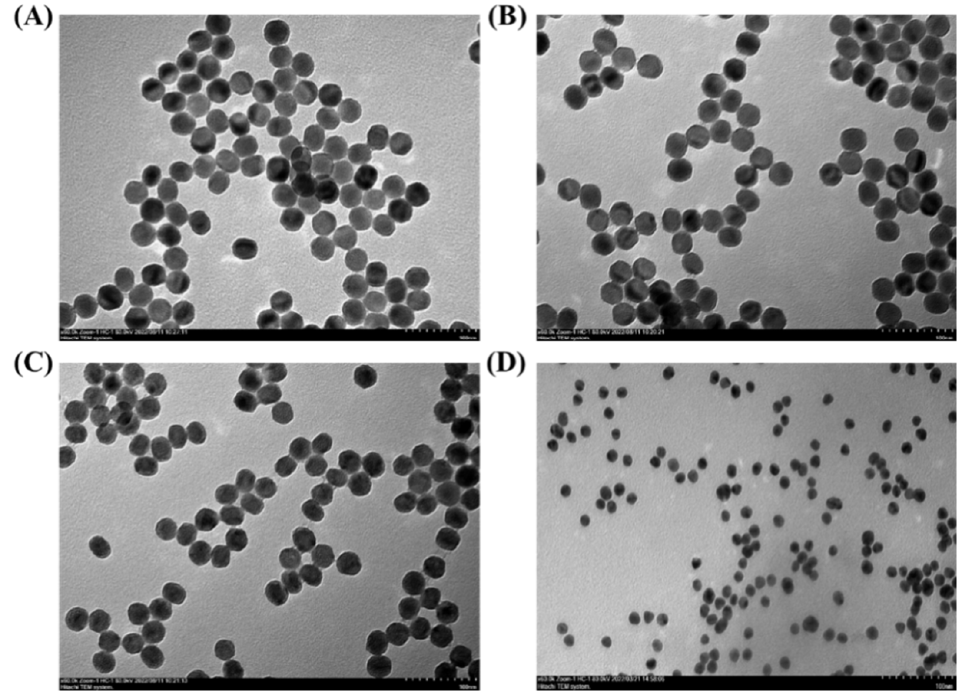
Figure 1. TEM image of OA − UCNPs ( A ), ADA − UCNPs ( B ), UCNPs − COOH ( C ), and GNPs ( D ).